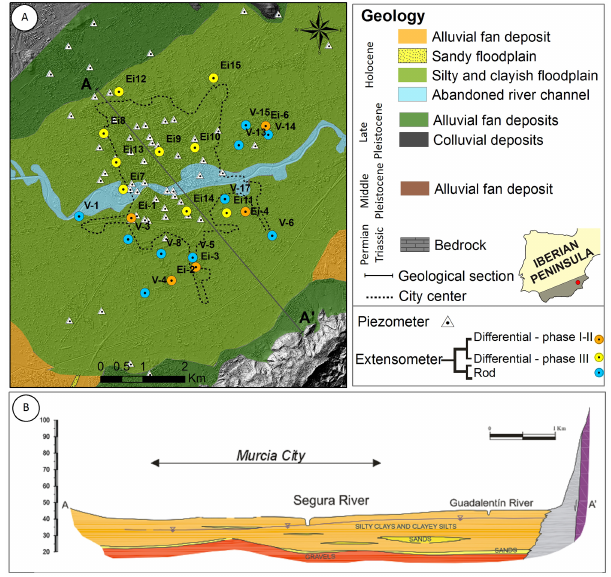
Figure 1. Geological Map (a) , Geological cross section of the study area (b) , (extracted from Mulas et al., 2003; modified after Tessitore et al.,